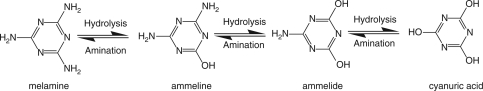
Chemical structure of melamine and related contaminants, and chemical processes that lead to conversion of melamine to different triazine analogs.